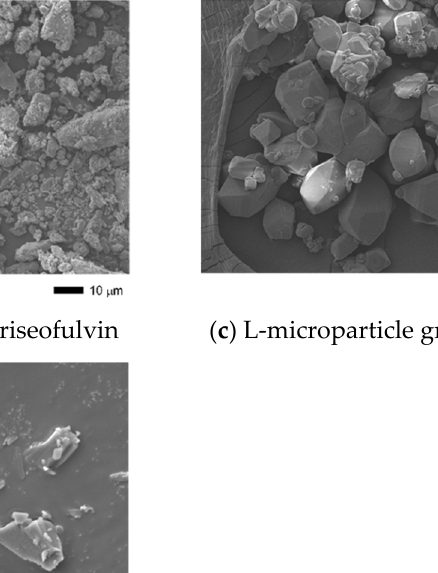
Figure 3. Scanning electron microscopy (SEM) image of griseofulvin samples ( a – c ) and hydrocorti- sone samples ( d , e ).